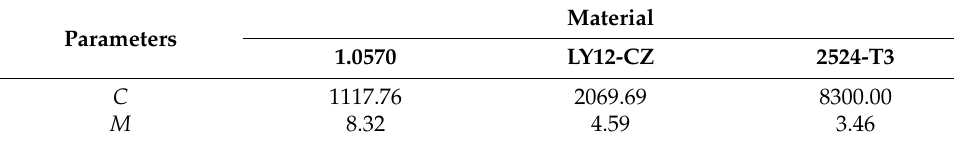
Table 1. Parameters of the s-n curve for the considered materials.